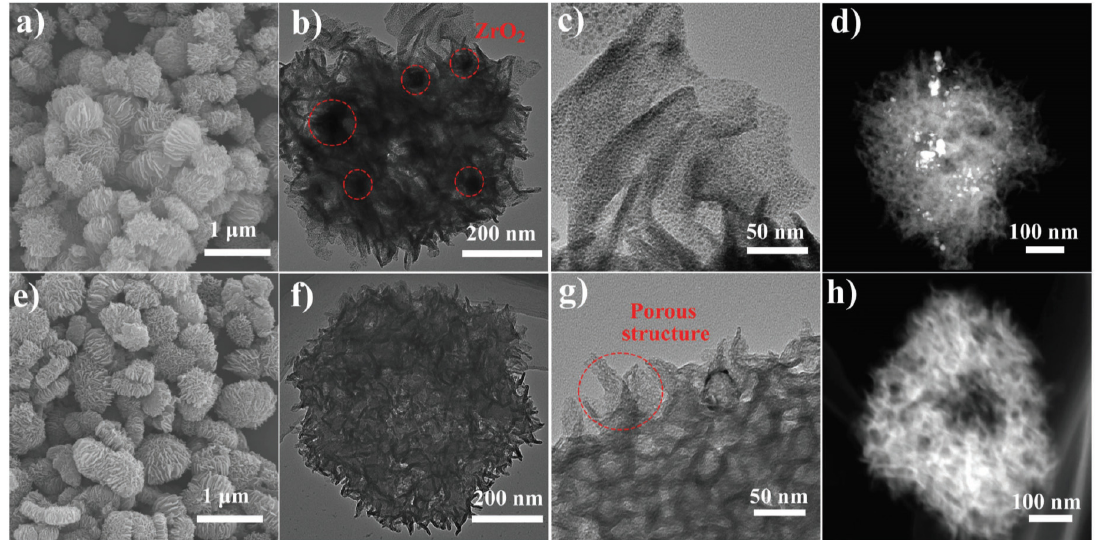
Figure 14. ( a ) SEM, ( b , c ) TEM, and ( d ) high-angle annular dark-field STEM (HAADF-STEM) images of the N-GCF-800 / ZrO 2 intermediate catalyst obtained before etching with HF. ( e ) SEM, ( f ) and ( g ) TEM, and ( h ) HAADF-STEM images of the N-GCF-800 catalyst. Reprinted and modified with permission from reference [108]. Copyright (2018) John Wiley and